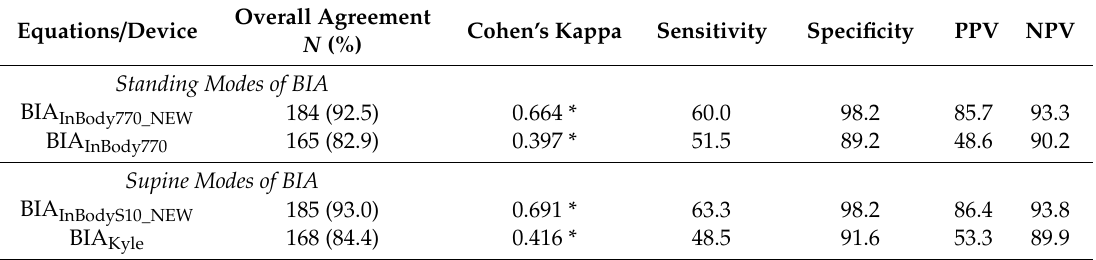
Table 5. Prevalence, sensitivity and specificity of the acceptable BIA equations to determine